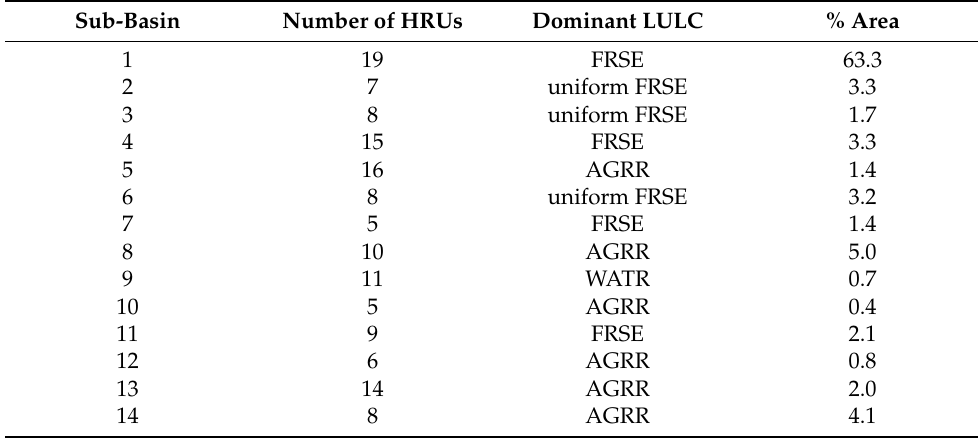
Table 6. Hydrologic response units and dominant LULC.